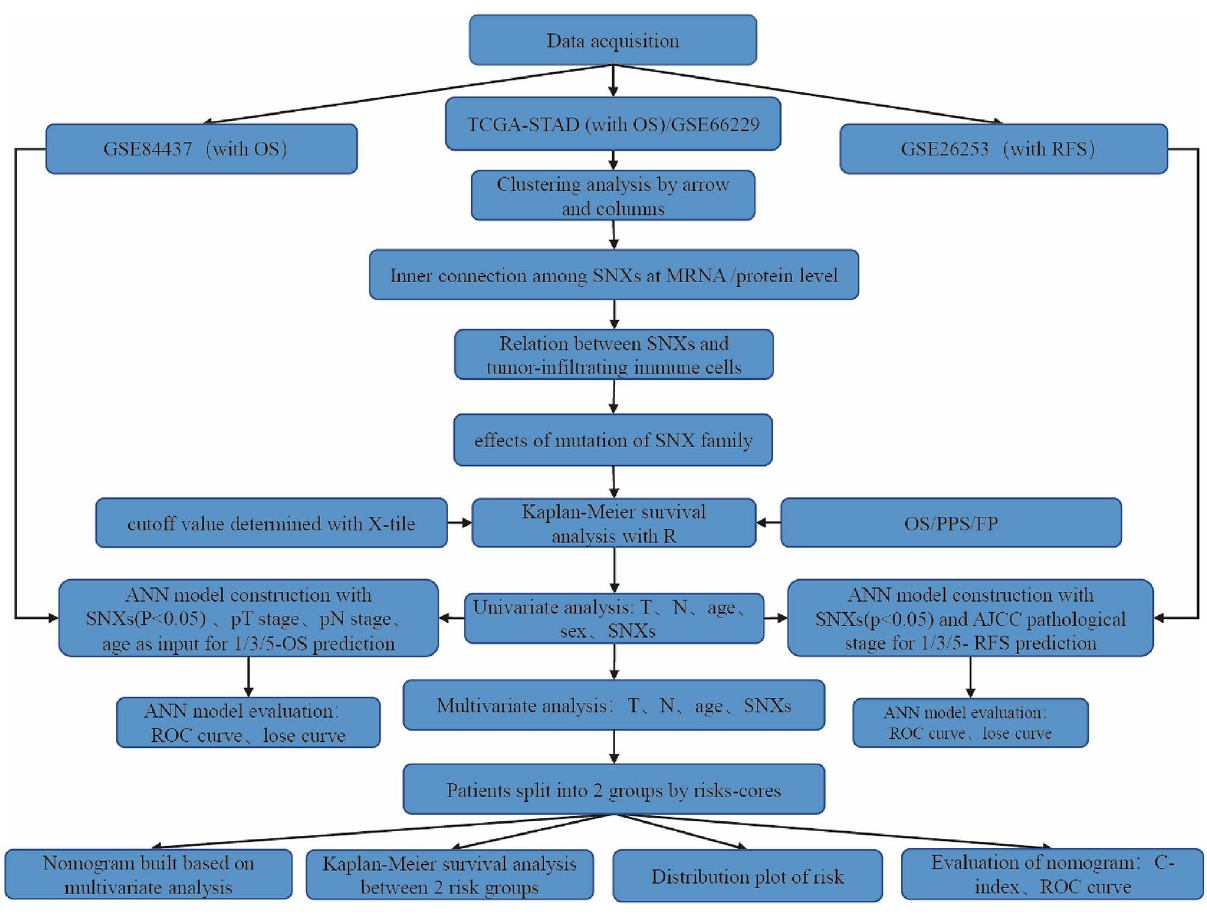
Figure 1. Workflow of this study. STAD, stomach adenocarcinoma; SNX, sorting nexin; OS, overall survival; RFS, relapse-free survival; PPS, post progression survival; PFS, progression-free